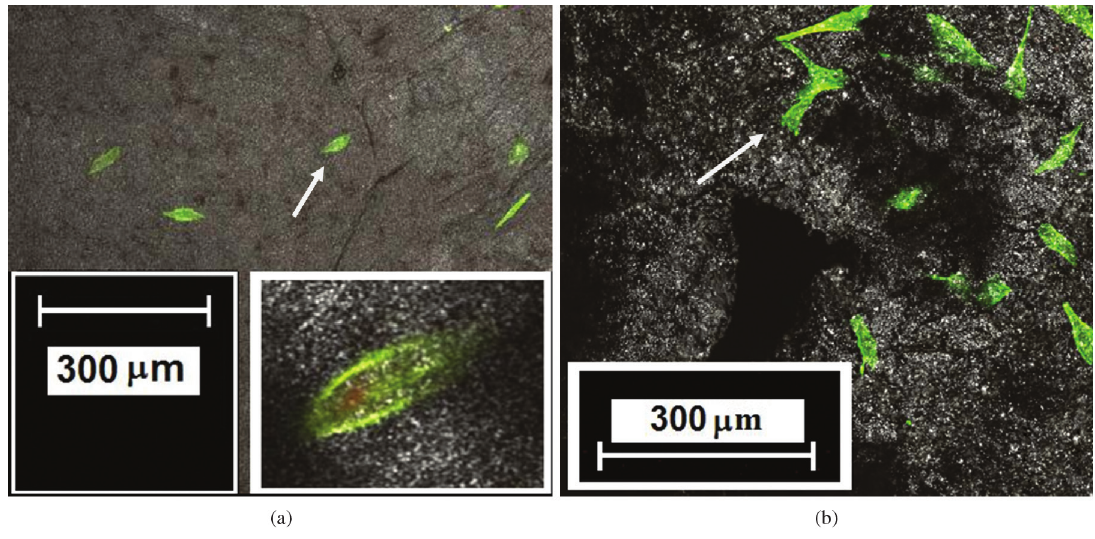
Figure 5. Cells adhered on scaffolds after 7 days. (a) Scaffold A. (b) Scaffold